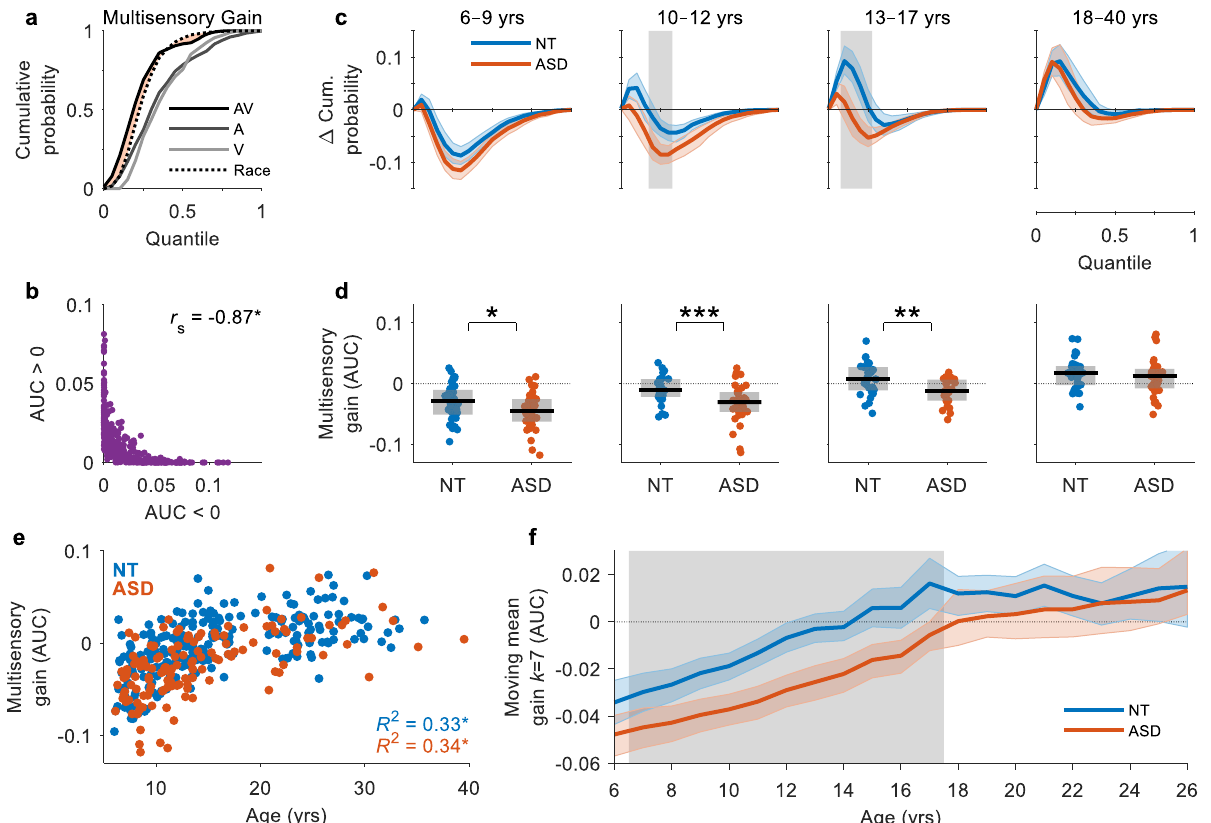
Fig. 3 Resolution of multisensory de fi cits in ASD. a RT cumulative probability for each of the three stimulus conditions and the race model. Multisensory gain is quanti fi ed by the area between the CDFs of the multisensory condition and the race model (Eq. 5). Data from an example NT adult participant. b The area under the curve (AUC) below zero is negatively correlated with the AUC above zero, providing information about participants that do not exhibit facilitation. c Race model violation for ASD (red trace) and sex, age, and IQ-matched NT (blue trace) participants by age group. Coloured error bounds indicate 95% CIs (bootstrapped). Gray shaded regions indicate signi fi cant group differences ( p < 0.05, two-tailed permutation tests, t max corrected). d Multisensory gain by age group. Boxplots indicate the median value (black line) and interquartile range (grey box). Each datapoint represents the AUC of an individual participant (blue = NT, red = ASD). Brackets indicate unpaired statistical comparisons (* p < 0.05, ** p < 0.01, *** p < 0.001, two- tailed permutation tests, FDR corrected). e Multisensory gain as a function of age for NT (left) and ASD (right) individuals. Each datapoint represents the AUC of an individual participant. f Mean multisensory gain calculated with a moving window k of 7 years in increments of 1 year from 6 to 26 years for NT (blue trace) and ASD (red trace) participants. Participants were sex, age and IQ-matched within each 7-year window. Coloured error bounds indicate 95% CIs (bootstrapped). Gray shaded regions indicate signi fi cant group differences ( p < 0.05, two-tailed permutation tests, FDR